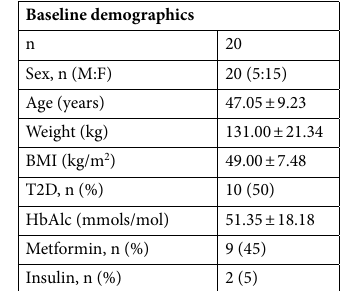
Table.1. Baseline demographics. All listed data are means ± standard deviation unless stated otherwise.